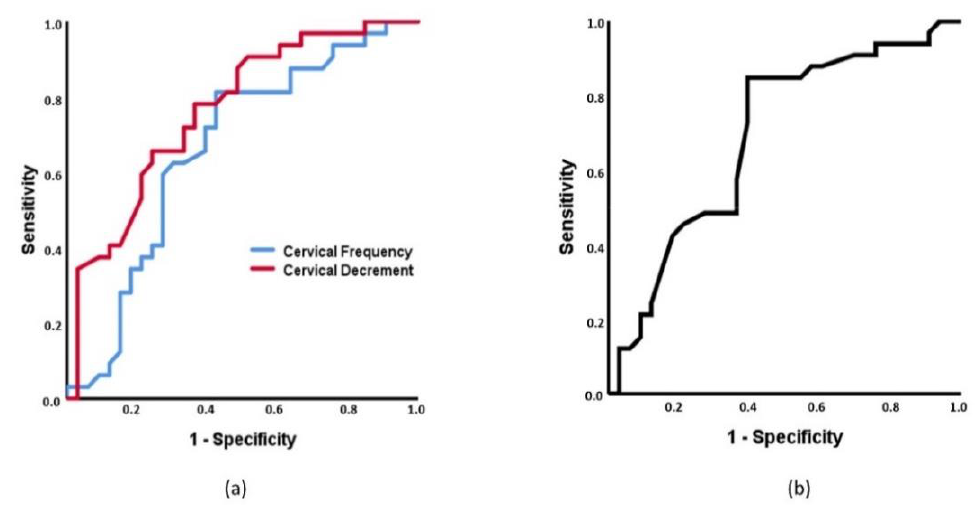
Figure 4. Receiver operating characteristic (ROC) curve of the cervical tone and decrement ( a ) and cervical flexion ( b ), to discriminate between individuals with acute neck pain and controls. ( a ) Area under the curve (AUC): for cervical tone = 0.663 (95% CI = 0.527–0.798); for cervical decrement = 0.764 (95% CI = 0.648–0.879). ( b ) AUC: cervical flexion = 0.691 (95% CI = 0.560–0.821).